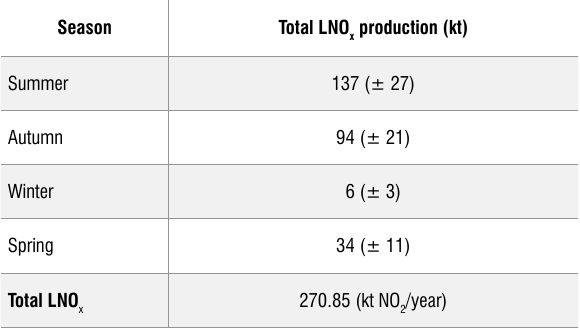
Seasonal and annual LNO excluding Lesotho and eSwatini Season